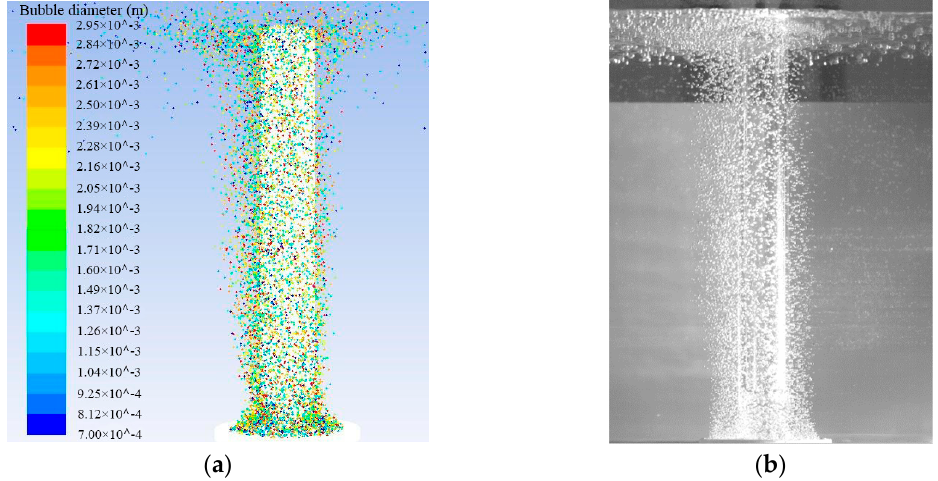
Figure 4. Distribution of argon bubbles in the tundish: ( a ) numerical simulation and ( b ) water model.